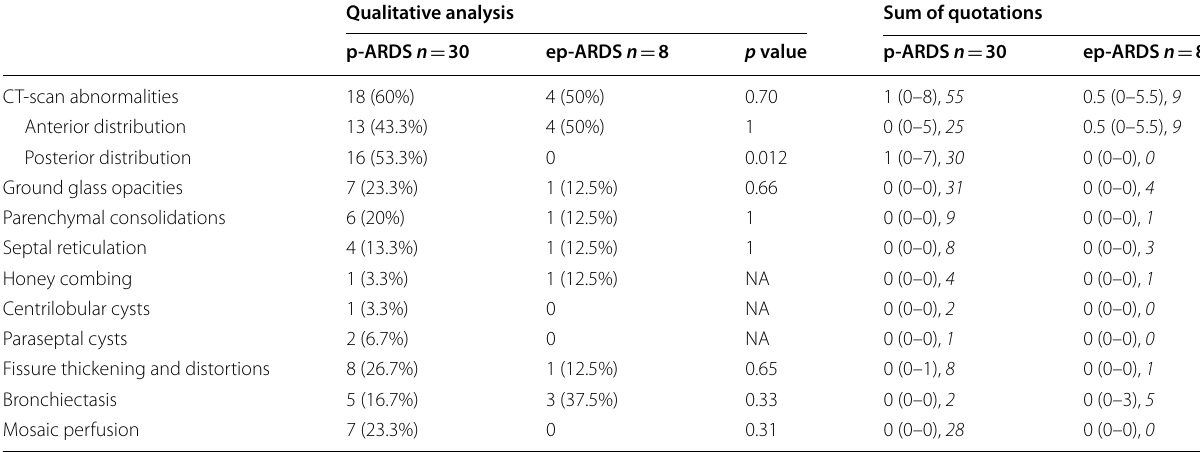
ep-ARDS extra-pulmonary ARDS. p-ARDS pulmonary ARDS. Left panel: % of children with abnormality. Right panel: medians of sum of quotations (interquartile ranges),